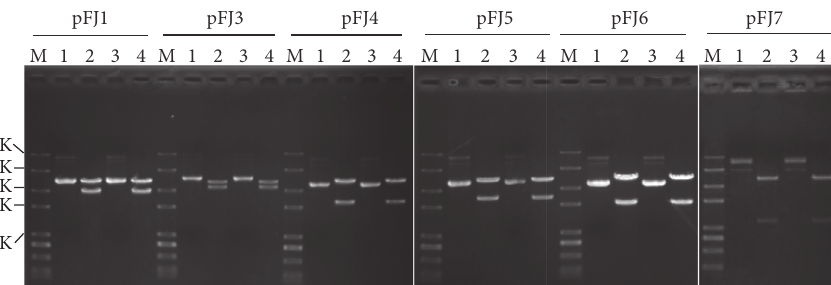
Figure 2: Structural stability of the shuttle vectors in J7-F cells. Pretransformed plasmids (extracted from E. coli before being transformed into J7-F, lanes 1 and 2) and back-transformed plasmid (extracted from E. coli following transformation into J7-F, lanes 3 and 4) were digested with restriction enzymes to compare their structural stabilities. M, 2 kb plus II marker; lanes 1 and 3, undigested plasmids; lanes 2 and 4, plasmids digested with Sna BI and Mfe